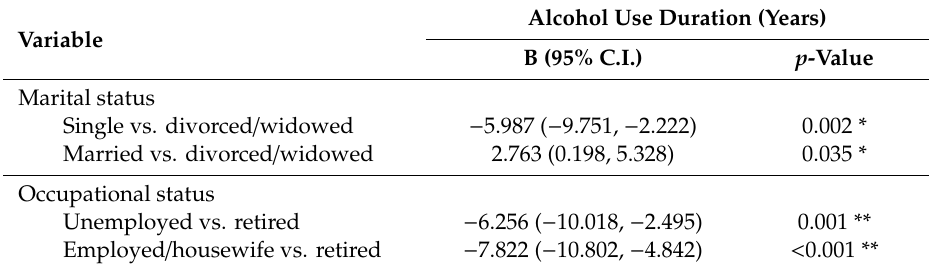
Table 4. Univariable analysis of association between alcohol use duration and marital status / occupational